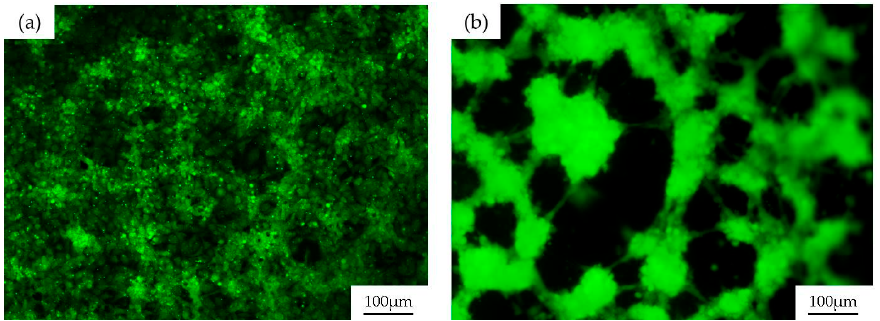
Figure 3. Representative fluorescence microscopy images of the human umbilical vein endothelial cells (HUVEC) growing over a PDMS channel after ( a ) the first and ( b ) the third use of the device; The channel was cleaned with ethanol. HUVECs were stained with green calcein AM.